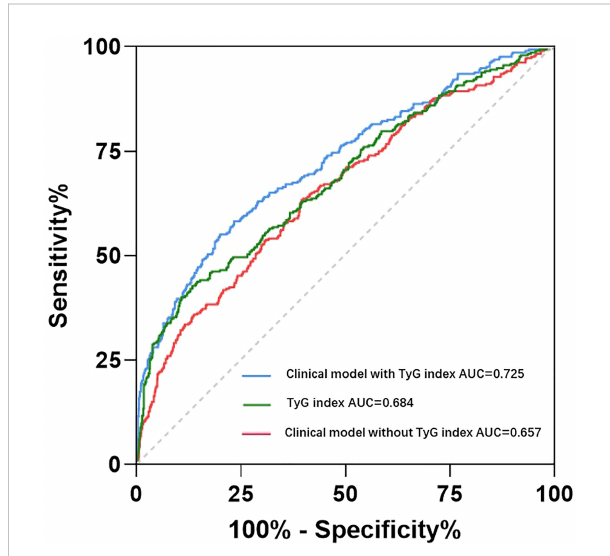
FIGURE 2 Receiver operating characteristic curve analysis of the TyG index and clinical with or without TyG index to predict incident HDP. Clinical model include age, pre-pregnancy BMI, family history of hypertension, and parity. AUC, area under